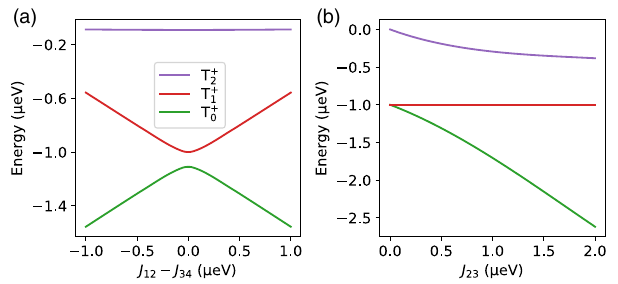
FIG. 6. Triplet energies. (a) Energies of global triplet states as a function of J 12 − J 34 , with J 23 ¼ 0 . 2 μ eV and J 12 þ J 34 ¼ 2 μ eV, revealing a minimum in energy difference at J 12 ¼ J 34 for T þ 0 and T þ 1 . (b) Triplet energies as a function of J 23 with J 12 ¼ J 34 ¼ 1 μ eV, showing that at J 12 ¼ J 23 ¼ J 34 the energy spac- ings are equal. The legend for (b) is the same as for (a). An external magnetic field results in an overall offset and, thus, does not change the triplet energy